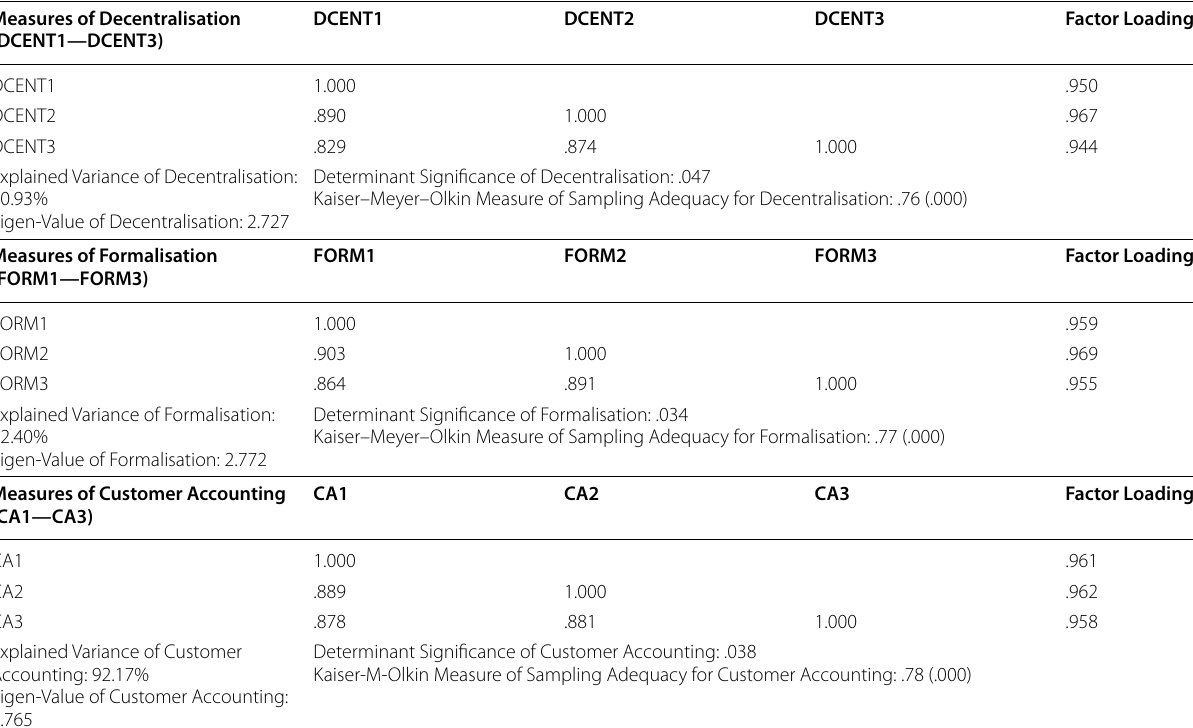
Table 5 Summary of Principal Component Analysis & Item Inter-Correlation Analysis for Decentralisation, Formalisation, and Customer Accounting ( n 115) =